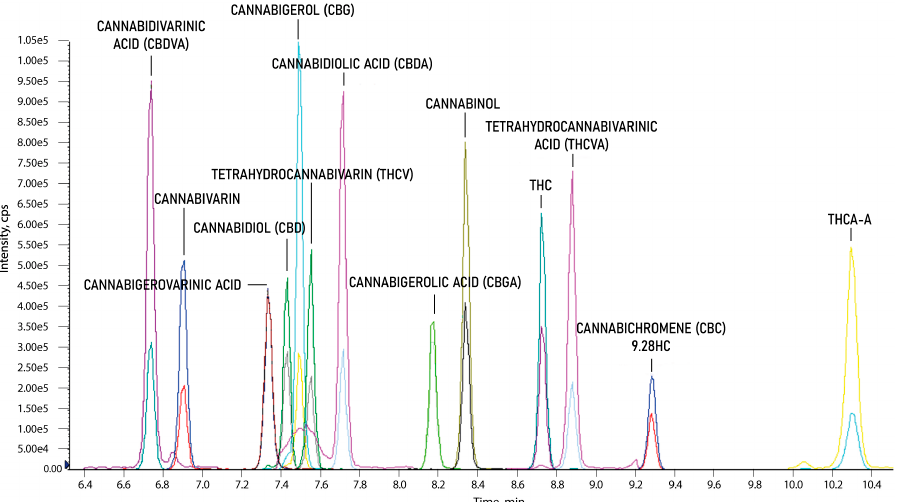
Figure 2. Chromatographic separation of 13 natural cannabinoids.